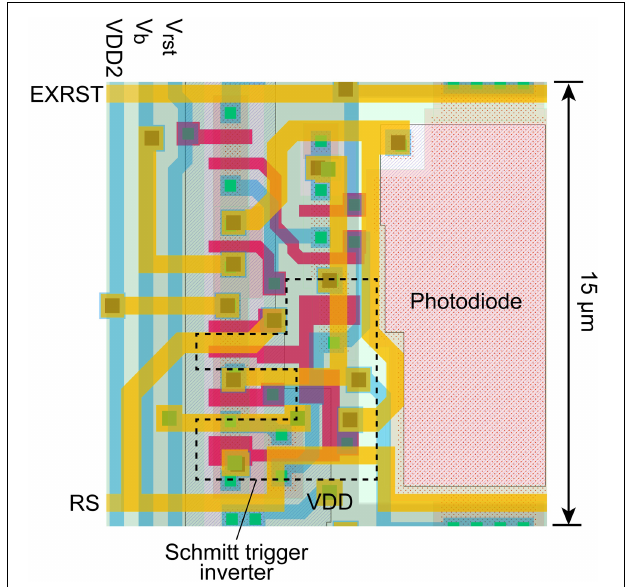
FIGURE 3 | Layout of the pixel with P+/N-well/P-sub photodiode.